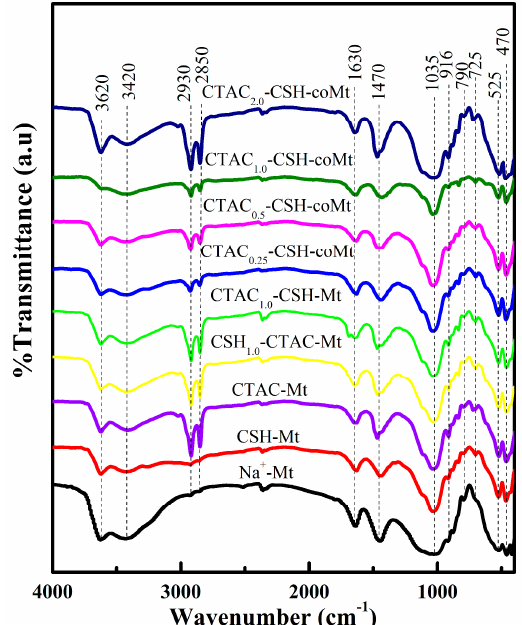
Figure 7. Fourier transform infrared spectra (FTIR) spectra of Na + -Mt and different OMt.